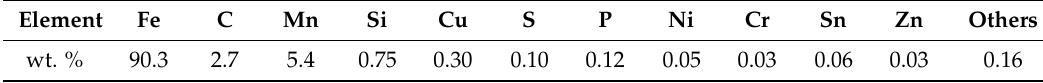
Table 8. Chemical composition of iron.